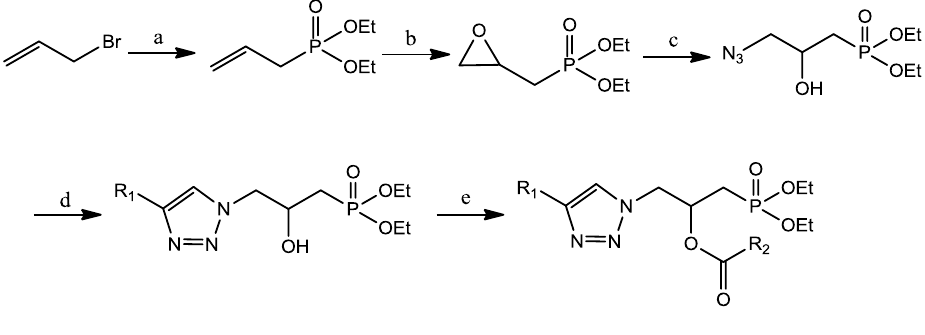
Scheme 1. Synthesis of the target compounds 5